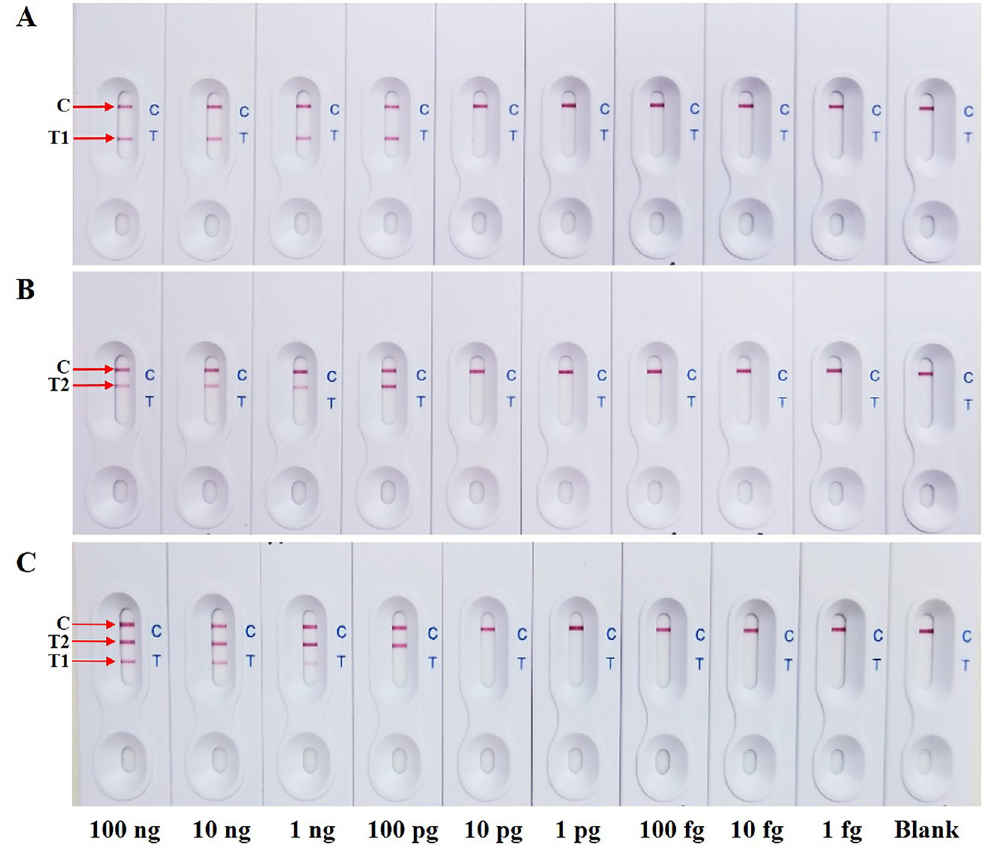
Fig 4. Analytical sensitivity of s-LAMP-LFB assay for a single target detection of (A) C . jejuni or (B) S . Typhimurium using each of serial dilution of target DNA. (C) Sensitivity limit of d-LAMP-LFB assay applied for simultaneous detection of both pathogens using 10-fold serial dilution of mixed genomic DNA ranged from 100 ng -1 fg per reaction. C: control line; T1: test line 1 of C . jejuni ; T2: test line 2 of S .